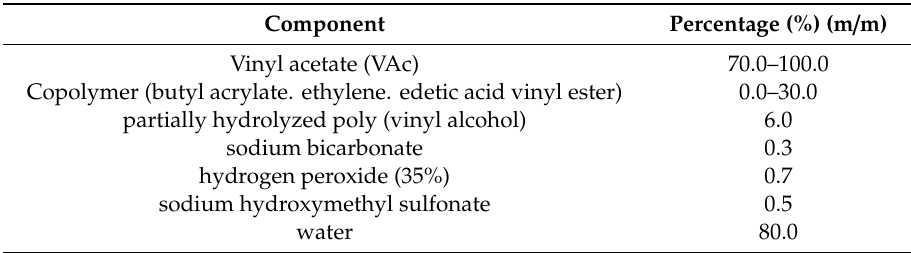
Table 2. Polymer EVA components [32].